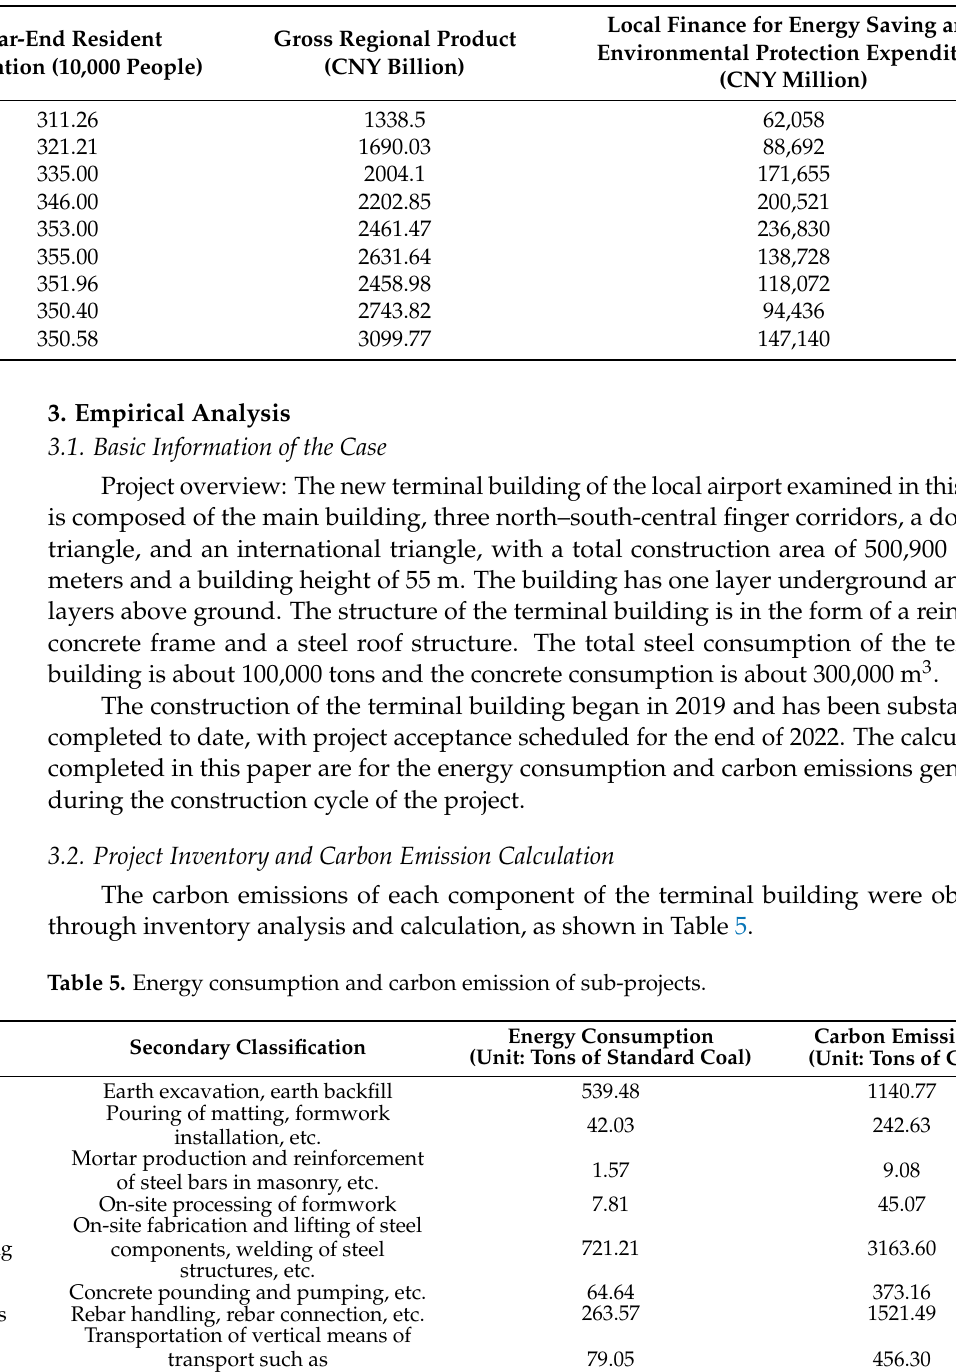
Table 4. Demographic and economic indicators statistical table.